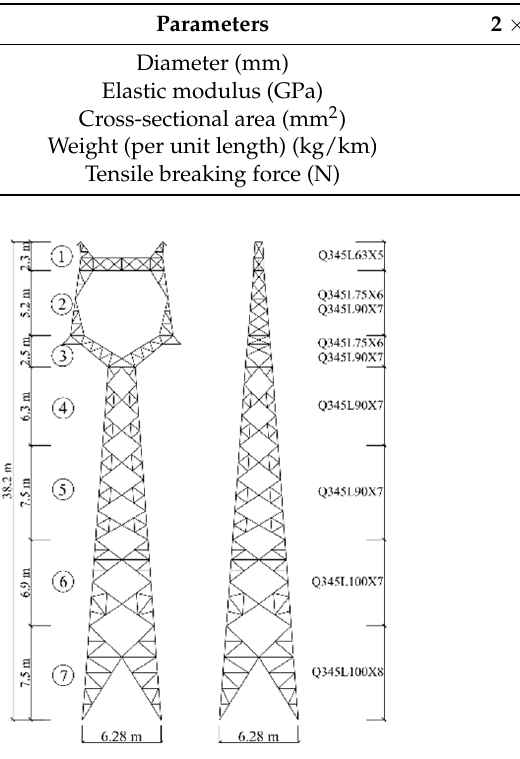
Table 1. Material parameters of the conductor and ground wire.